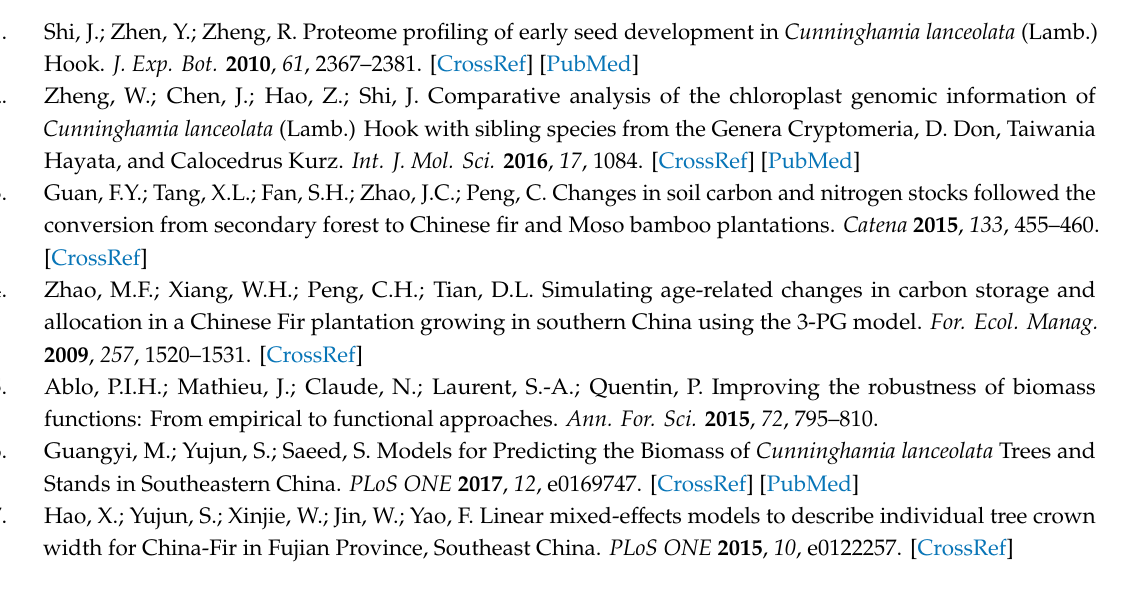
indices in this study, evaluated by F